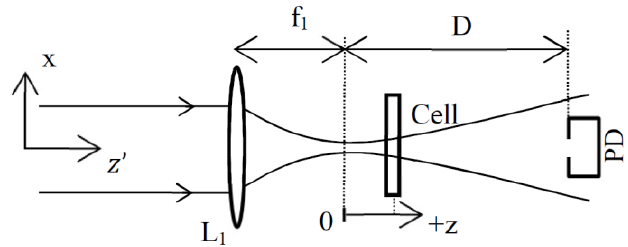
Figure 2. Scheme showing the different positions of the elements. The cell is scanned along the beam direction around the focal plane ( z = 0 ). The labels refer to: lens (L 1 ) and photodiode (PD).